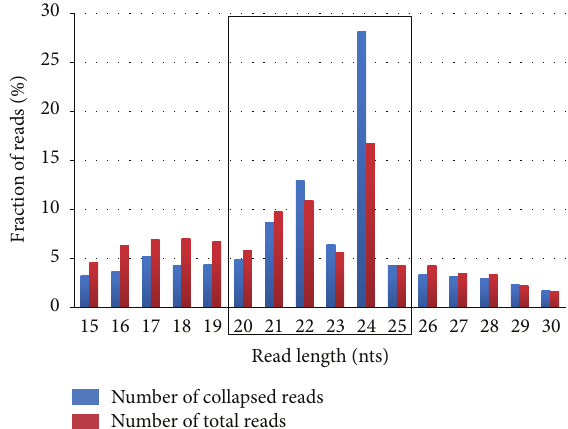
Figure 2: Frequency distribution of cassava small RNAs between 15 to 30nt. Reads with 20 to 25 nts (black box) in length were selected for further